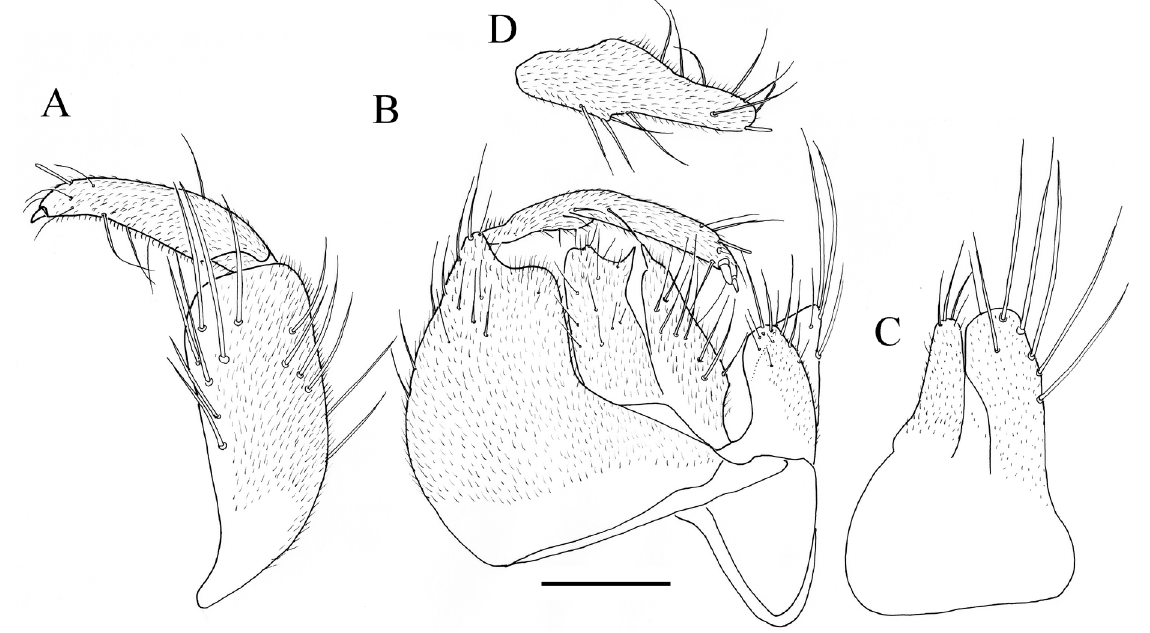
Fig. 3. Terminalia of Tachydromia apterygon Plant & Deeming, 2006 from Italy, Lazio, Posta (RBINS). A . Right surstylus and right epandrial lamella. B . Epandrium with cerci. C . Left epandrial lamella and left surstylus. D . Right surstylus. Scale bar: 0.1